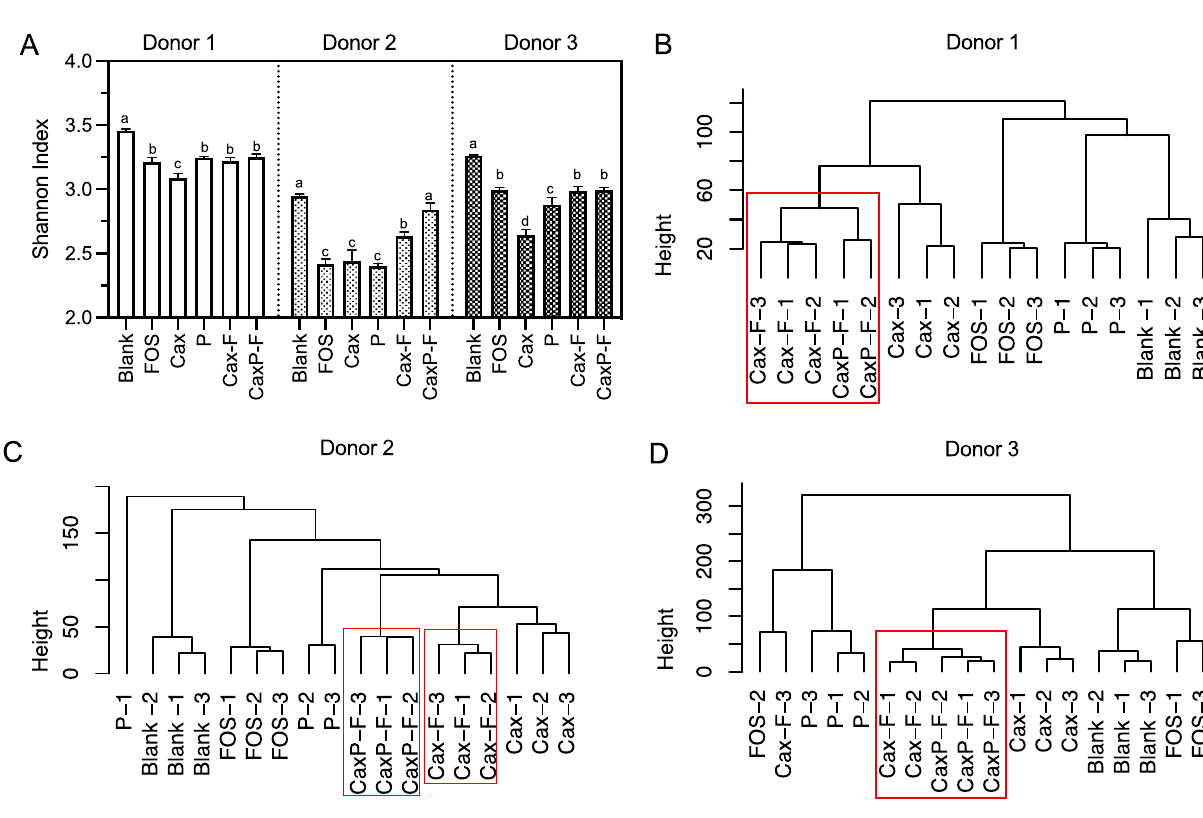
Figure 5. Microbiota diversity change after 24 h in vitro fecal fermentation; ( A ) Changes in Shannon alpha diversity for each donor fecal microbiota community of soluble and film fibers. Different letters indicate significant differences between substrates at the same time point (α = 0.05). Hierarchical cluster analysis tested fiber using the Ward agglomerative algorithm on Euclidean distances for ( B ) Donor 1, ( C ) Donor 2 and ( D ) Donor